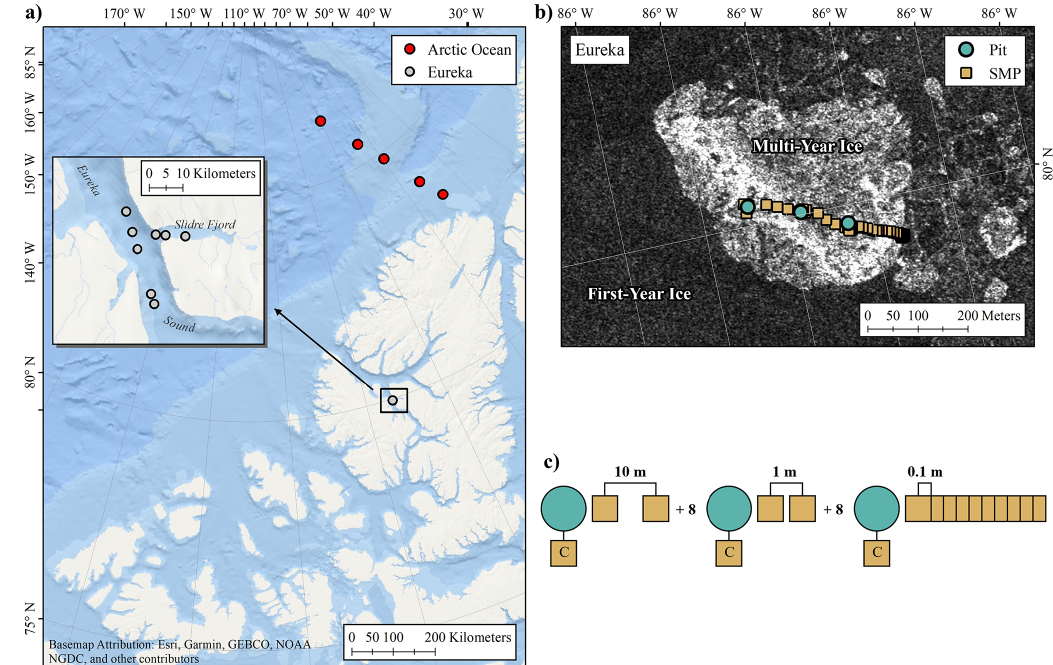
Figure 1. Overview of the Eureka and Arctic Ocean (AO) snow on sea ice campaigns (a) . Unidirectional SnowMicroPen (SMP) transects were collected at multiple sites to evaluate spatial variability of snowpack properties ( b ; Eureka MYI site shown) with sets of 10 profiles separated at distances of 0.1, 1, and 10m, in sequence (c) . Co-located SMP profiles were collected at all snow pit locations to calibrate the SMP density model of Proksch et al. (2015). Background of (b) shows RADARSAT-2 imagery near Eureka where bight returns indicate rough multi-year ice. RADARSAT-2 data and products © MacDonald, Dettwiler and Associates Ltd. (2019). All rights reserved. RADARSAT is an official trademark of the Canadian Space Agency. Table 1. Summary of measurements completed as part of the Eureka (E) and Arctic Ocean (A) campaigns. Site